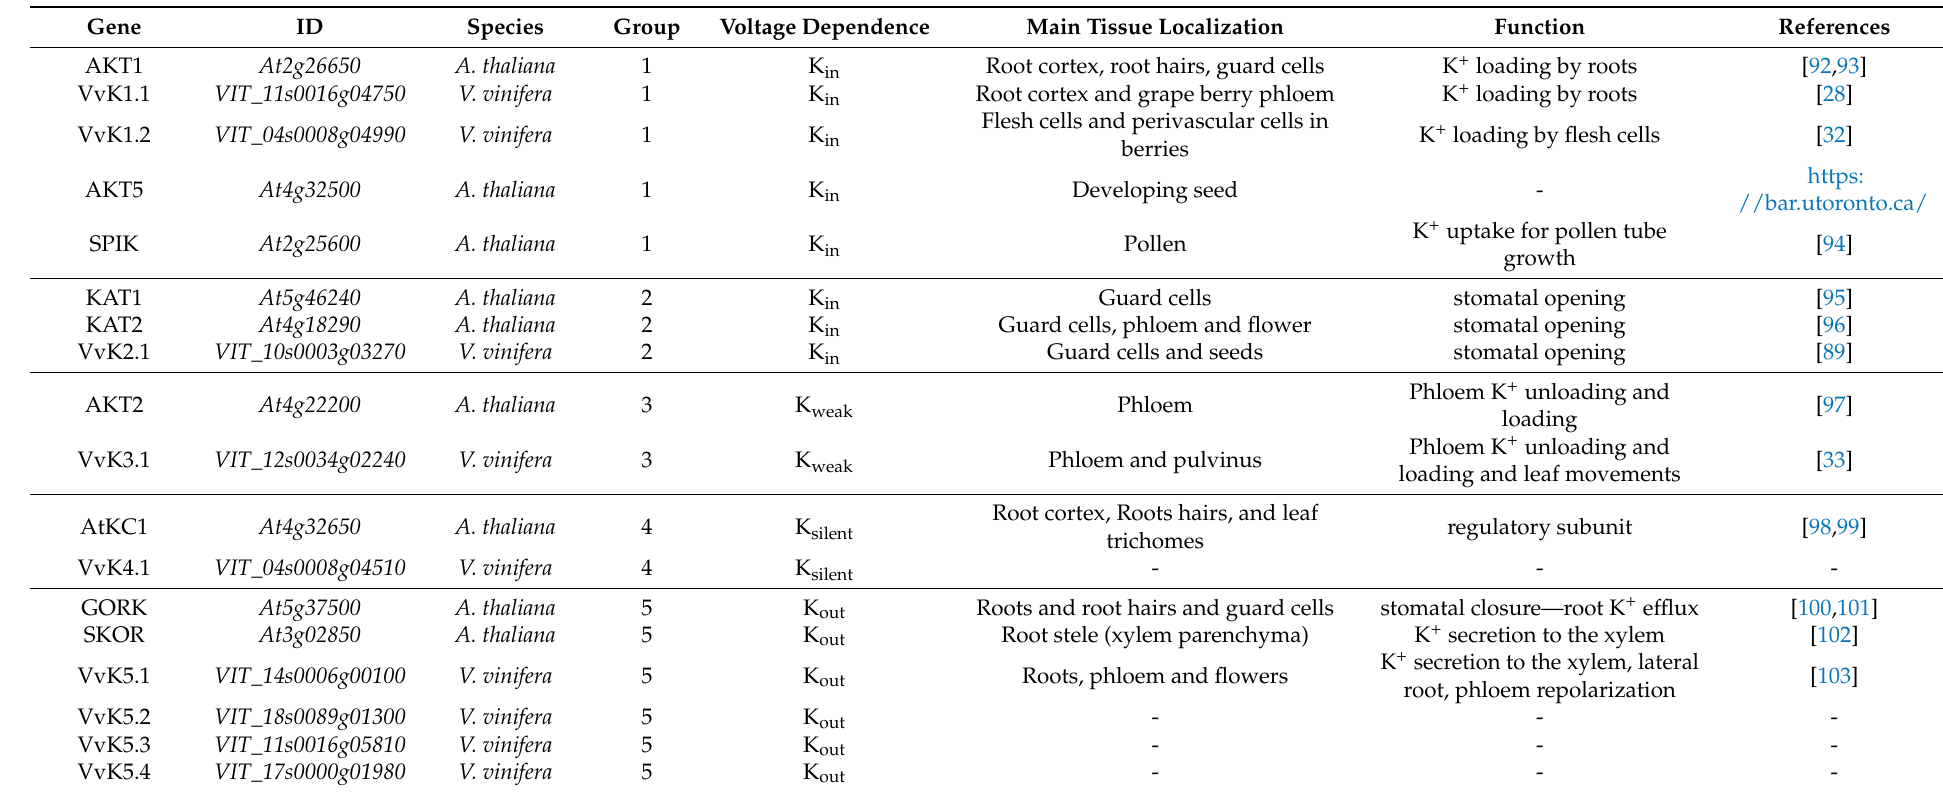
Table 1. Arabidopsis and grapevine Shaker-like voltage-gated K + channels. Abbreviations: Channel subunits K in , K weak , and K out form homomeric inwardly rectifying, weakly inwardly rectifying, or outwardly rectifying channels. The channel K silent is silent (non-functional) when expressed alone but forms a functional heterotetrameric channel with K in and K weak